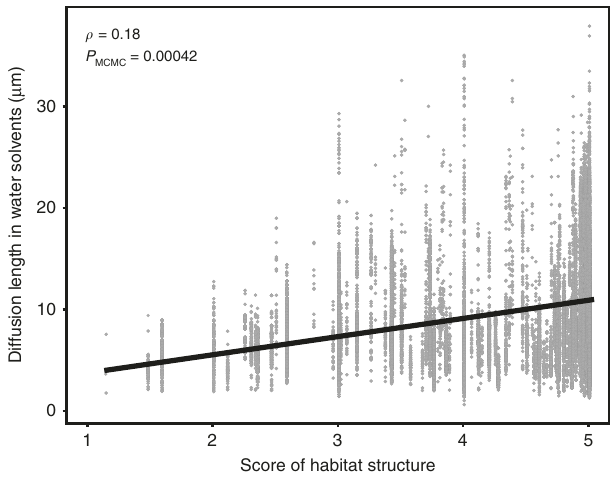
Fig. 3 Diffusion length of extracellular proteins in function of the score of environmental structure. Source data are provided as a Source Data fi